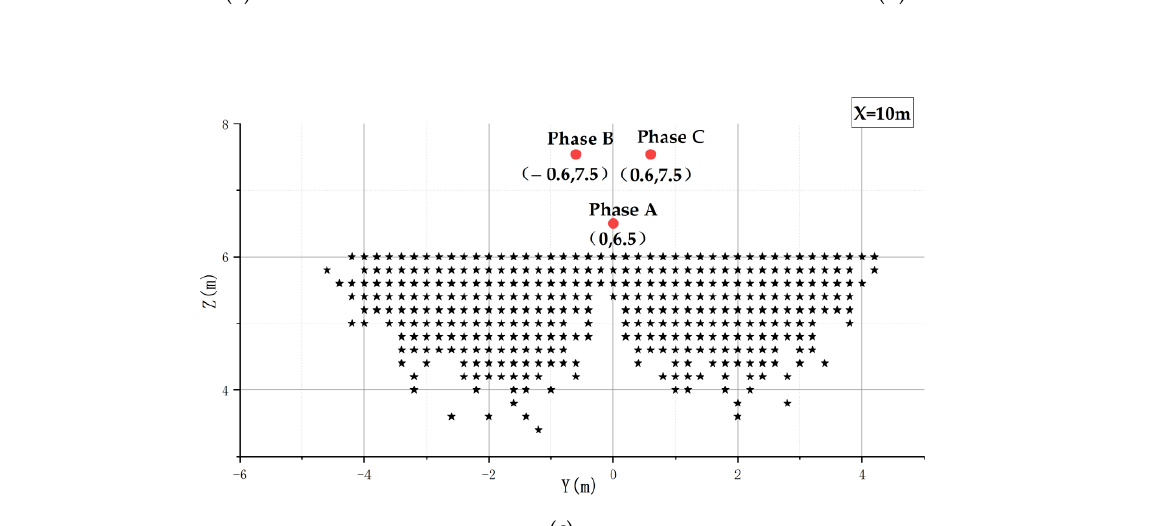
Table 5. Data transmission line around electric field scanning point.